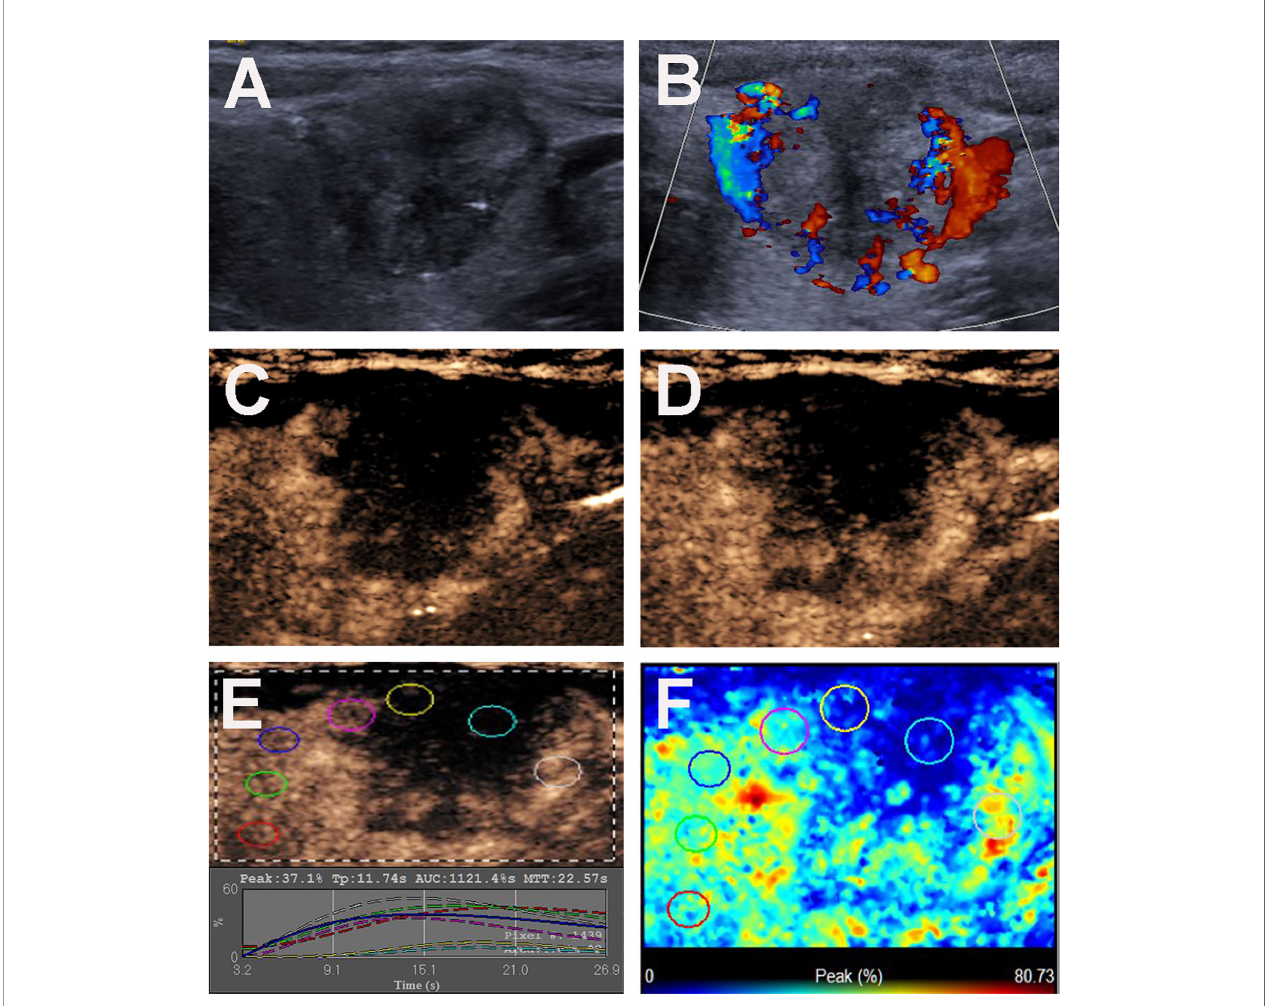
FIGURE 2 | Conventional US and CEUS images of a 36-y-old female PTC patient with Hashimoto ’ s thyroiditis of the left thyroid lobe with CLNM. (A) B-mode US image revealing an 18.6-mm solid thyroid nodule with hypo-echogenicity, ill-de fi ned margins, microcalci fi cation, capsule contact with protrusion and halo sign. (B) Doppler image revealing abundant peripheral and slight internal vascularity. (C, D) CEUS images revealing a centripetal heterogeneous hypo-enhancement with a surrounding incomplete ring of thyroid nodule from the periphery to the center, at (C) 8s (wash-in) and (D) 13s (time to peak). (E) TICs of the thyroid nodule and peripheral thyroid parenchyma with different ROIs (different color circles). (F) Parametric color map indicating the PI values for the center of nodule was lower than those of the periphery of nodule and adjacent thyroid